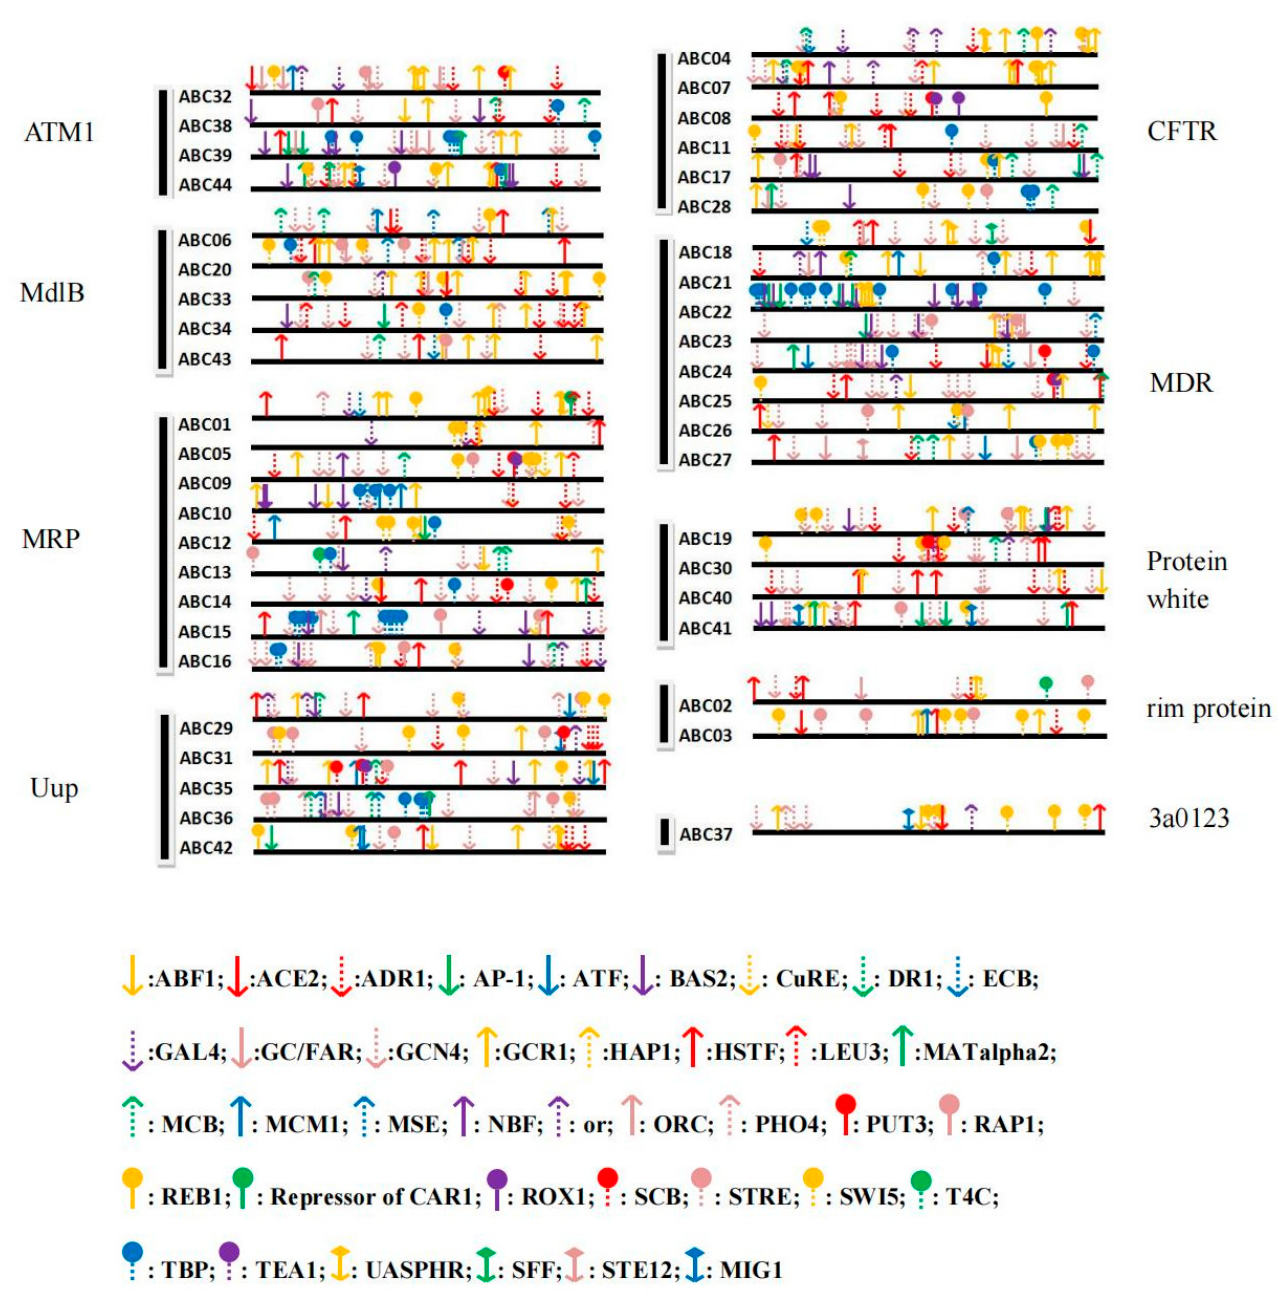
Figure 4. Regulatory element-binding motifs in the promoters of the 44 ABC transporter genes in Trichoderma asperellum .